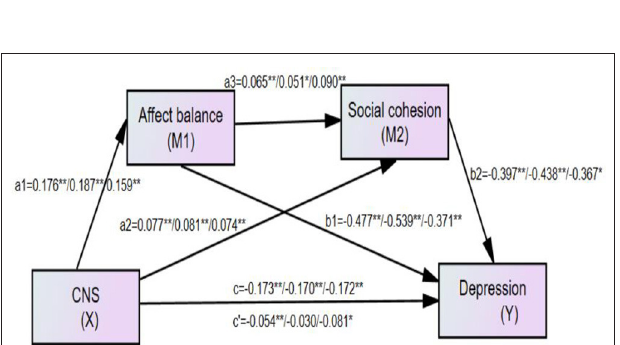
FIGURE 3 | The finalized structural model concerning the relationship between connectedness to nature and depression: affect balance and social cohesion as mediators. Left numbers, the full sample ( N = 675); Middle number, the adult sample ( N = 386); Right number, the old people sample ( N = 288); c ′ , the direct effect from connectedness to nature to depression; c, total effect from connectedness to nature to depression. **Correlation is significant at the 0.01 level. *Correlation is significant at the 0.05